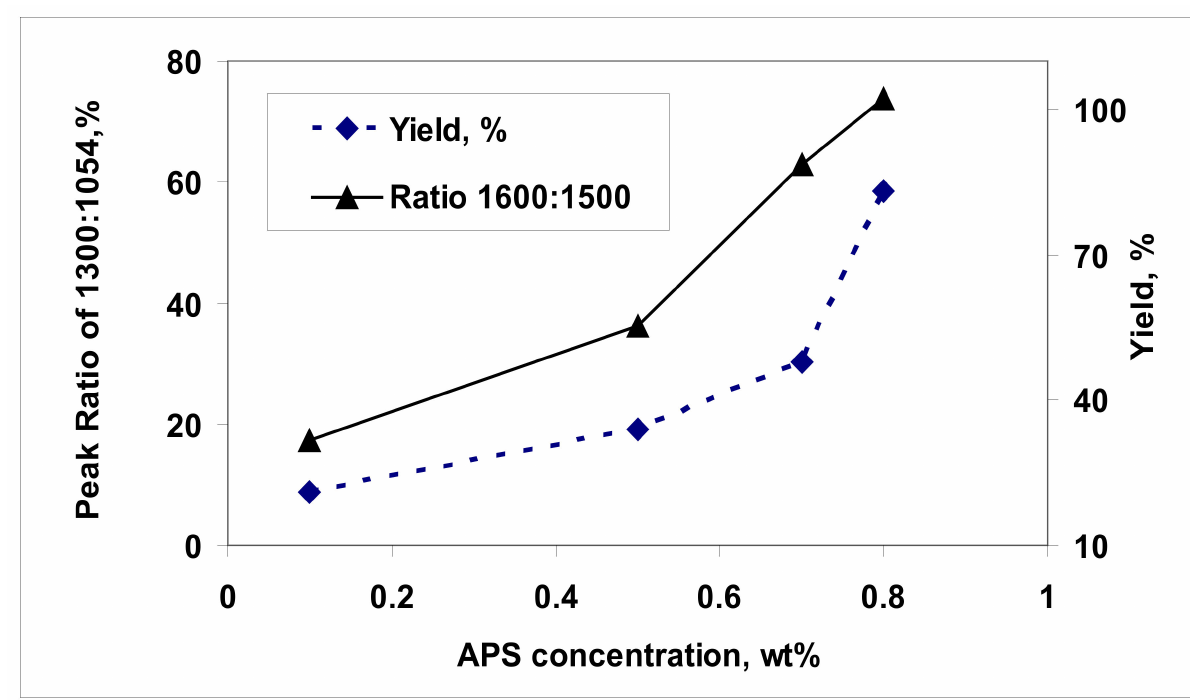
Figure 6. Variation of ratio of 1300 to 1054 cm − 1 peak heights with APS